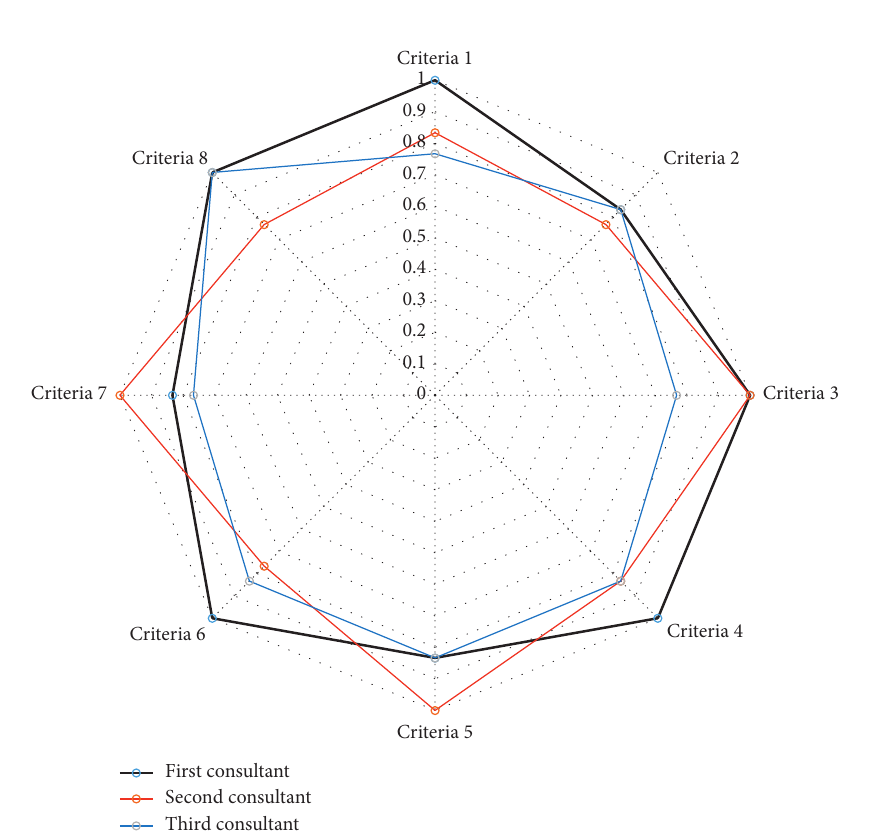
Figure 1: Percent agreement among raters for the eight prespecified criteria used for evaluation of the twelve patients.